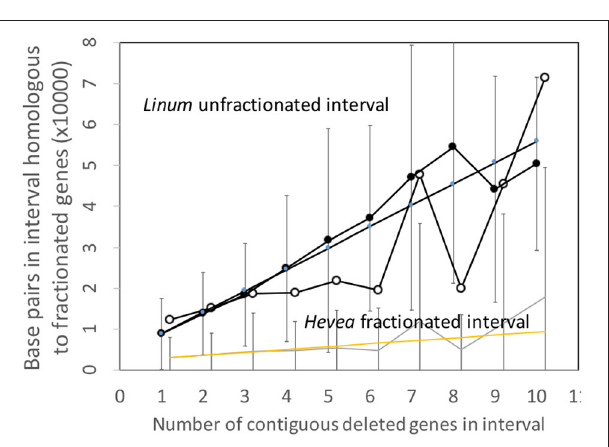
FIGURE 6 | Comparison of DNA content in unfractionated and fractionated (conserved and reduced) intervals in the Linum and normalized Hevea